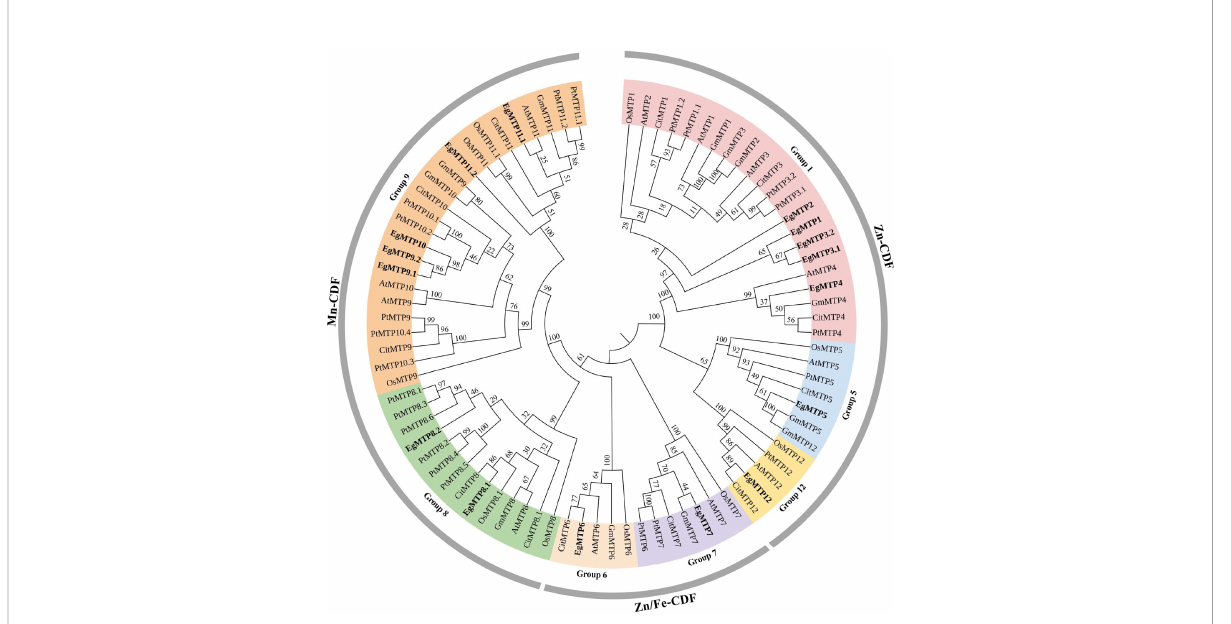
FIGURE 3 Phylogenetic relationships of MTP. The neighbor-joining tree was generated using MEGA 7.0 with 1,000 bootstrap replicates. E. grandis MTP proteins were in bold. At, Arabidopsis thaliana ; Os, Oryza sativa ; Gm, Glycine max ; Pt, Populus trichocarpa ; Cit, Citrus sinensis ; Eg, Eucalyptus grandis